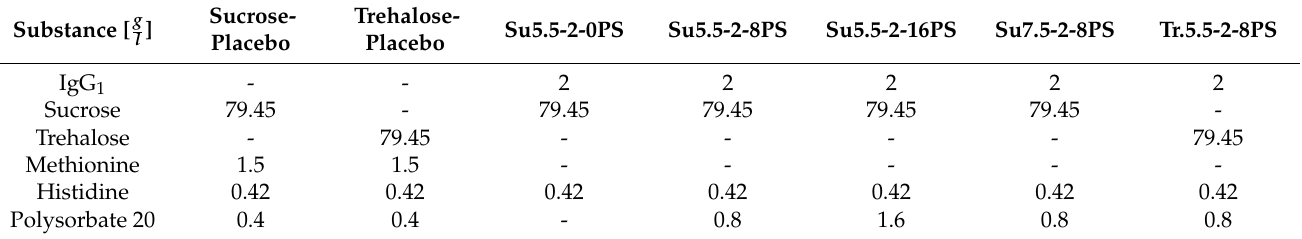
Table 1. Compositions of formulations used in the different